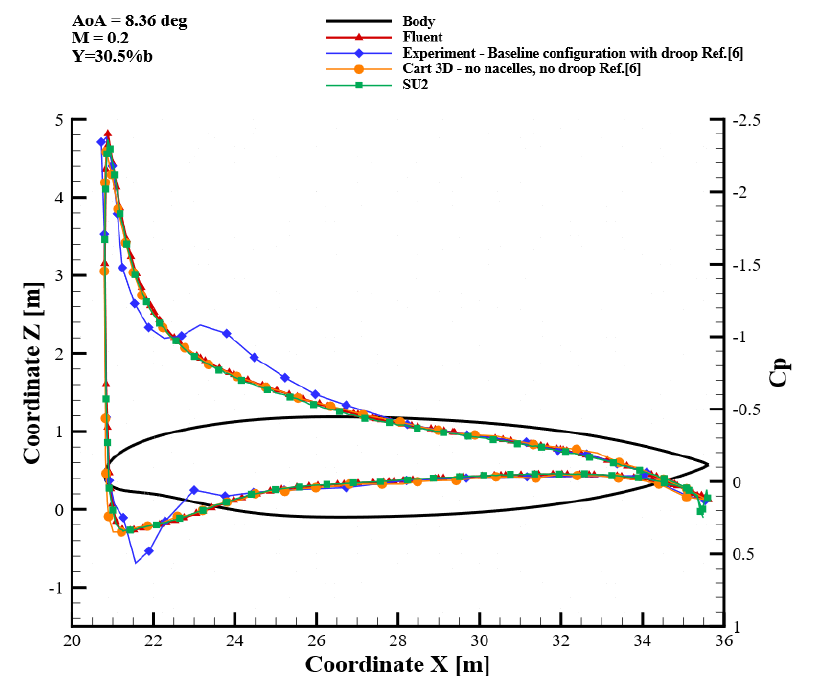
Figure 17. Chordwise pressure distribution at β = 30.5%, comparison between present results and literature data.